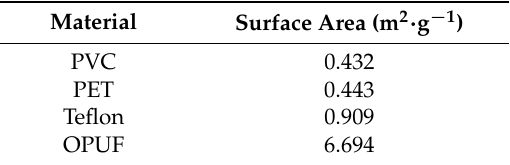
Table 2. Packing material characteristics